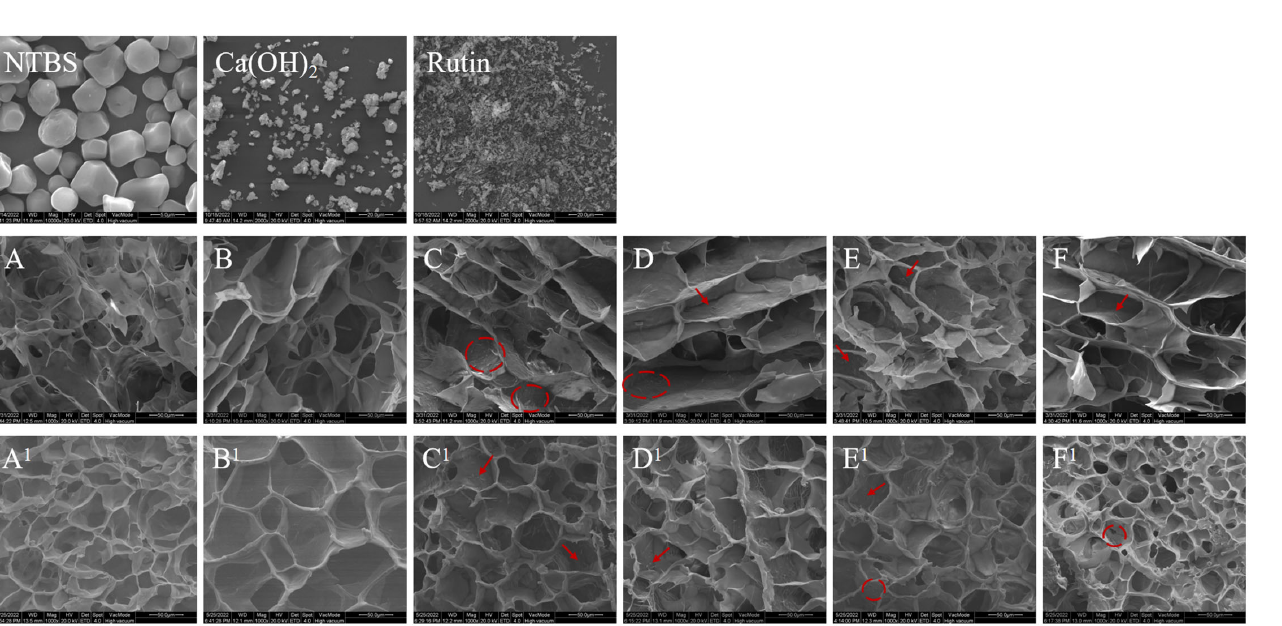
Figure 2. Scanning electron microscopy of nature TBS (NTBS), Ca(OH) 2 , rutin, gelatinized TBS (GTBS), GTBSCa, pre-TBSR, pre-TBSRCa, TBSR, and TBSRCa complexes gelatinization ( A – F ) and after regeneration ( A 1 – F 1 ).